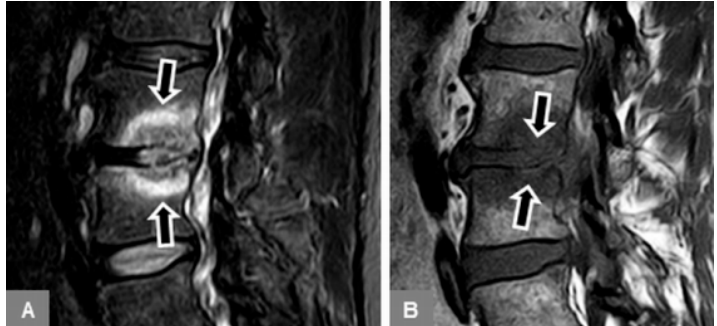
Figure 2. Early spondylodiscitis. A 63-year-old male patient with vertebral bone marrow edema on a sagittal STIR image at L3/L4 ( A , arrows), with blurred, discontinuous endplate contours on a sagittal T1-w image ( B , arrows).